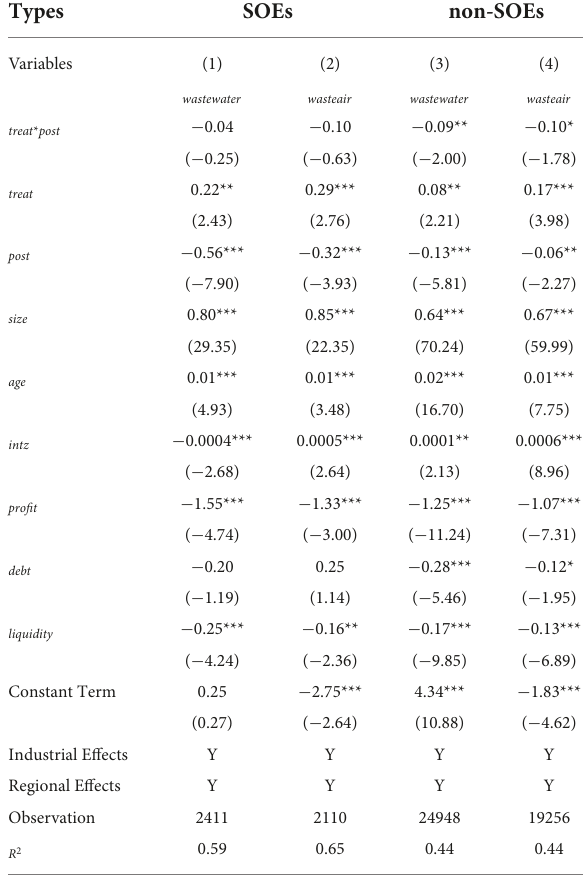
TABLE 3 Regression results of subsamples by enterprise